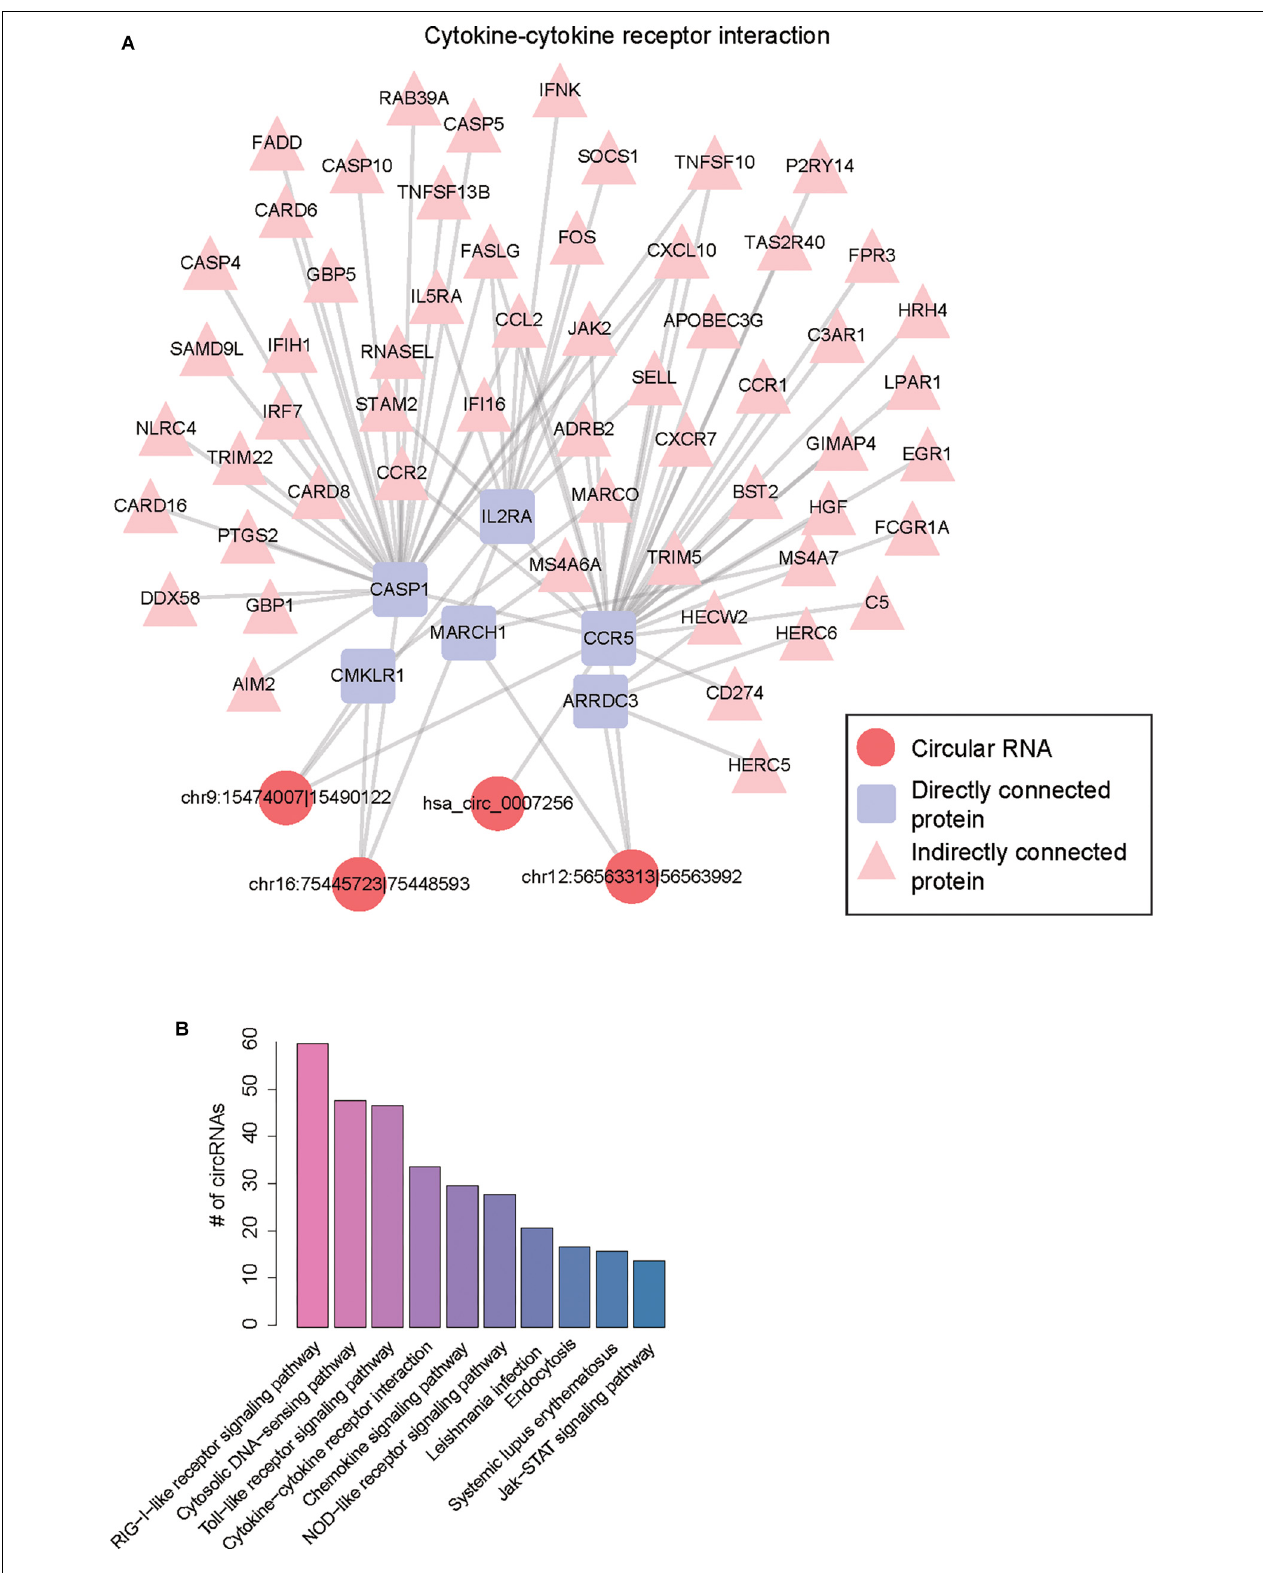
FIGURE 5 | Functional annotation of dysregulated circRNAs by merging ceRNA and PPI network. (A) The merged network involving protein-protein and circRNA-mRNA interactions. (B) The number of circRNAs for the top-ten most frequently enriched pathways.